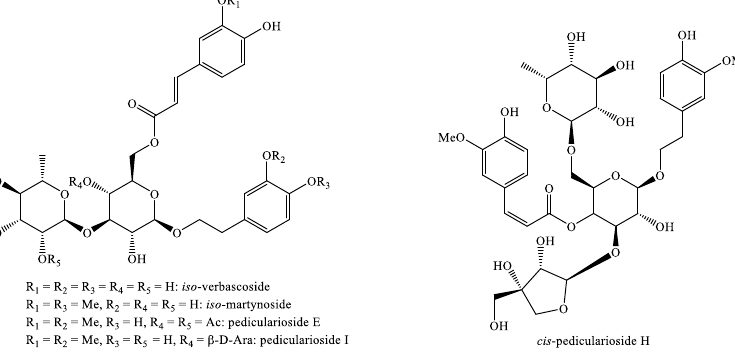
Figure 11. Phenylethanoid glycosides identified in Pedicularis species—part 2.